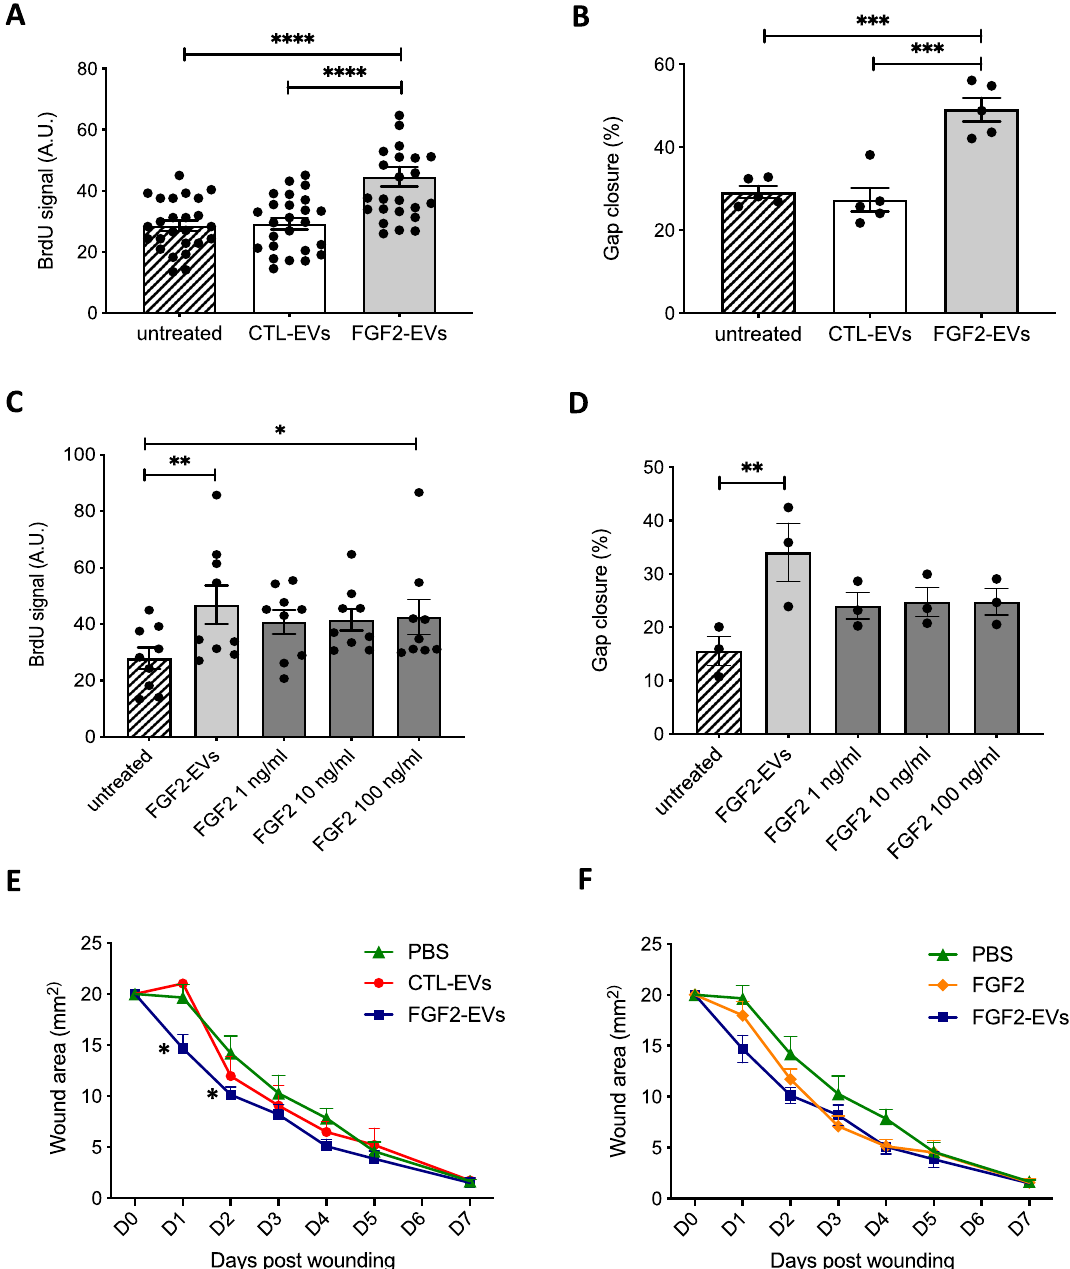
Figure 5. FGF2-EVs activate fibroblast functions. The effect of CTL-EVs and FGF2-EVs was assessed on DF proliferation ( A , C ) and migration ( B , D ). DF proliferation was assayed by BrDU incorporation 48 h after treatment with PBS (untreated), CTL-EVs or FGF2-EVs. Fibroblast migration was assayed by wound gap closure assay. PBS, CTL-EVs or FGF2-EVs were added immediately after insert removal; gap closure was measured 48 h later. ( A , B ) Statistical significance was determined by one-way ANOVA, ****< 0.0001, ***< 0.001. ( C , D ). The effect of FGF2-EVs was compared with different concentrations of recombinant FGF2 from 1 to 100 ng/ml in proliferation and migration assays. The data are mean ± SE of 3–4 independent experiments. Statistical significance was determined by one-way ANOVA **< 0.01, *≤ 0.05. ( E , F ) The effect of FGF2-EVs was assayed in vivo through a cutaneous wound assay in mice. Following wound (D0), EVs (1.5E + 9p) in a volume of 125 μl were given to each mouse, of which 25 μl were topically applied on the wound and 100 μl were injected in four locations surrounding the wound. Pictures were taken daily from day (D) 0 to D5 as well as on D7 and used for wound area quantification. Results are mean ± SE from one representative experiment with n = 2 (non- injected), n = 3 (PBS) and n = 5 for CTL-EVs and FGF2-EVs. Statistical significance was determined by two-way ANOVA with Tukey’s correction of multiple comparison: significance was found on D1 for FGF2-EVs compared to PBS (*< 0.05) and CTL-EVs (**< 0.005) and on D2 for FGF2-EVs compared to PBS (*<